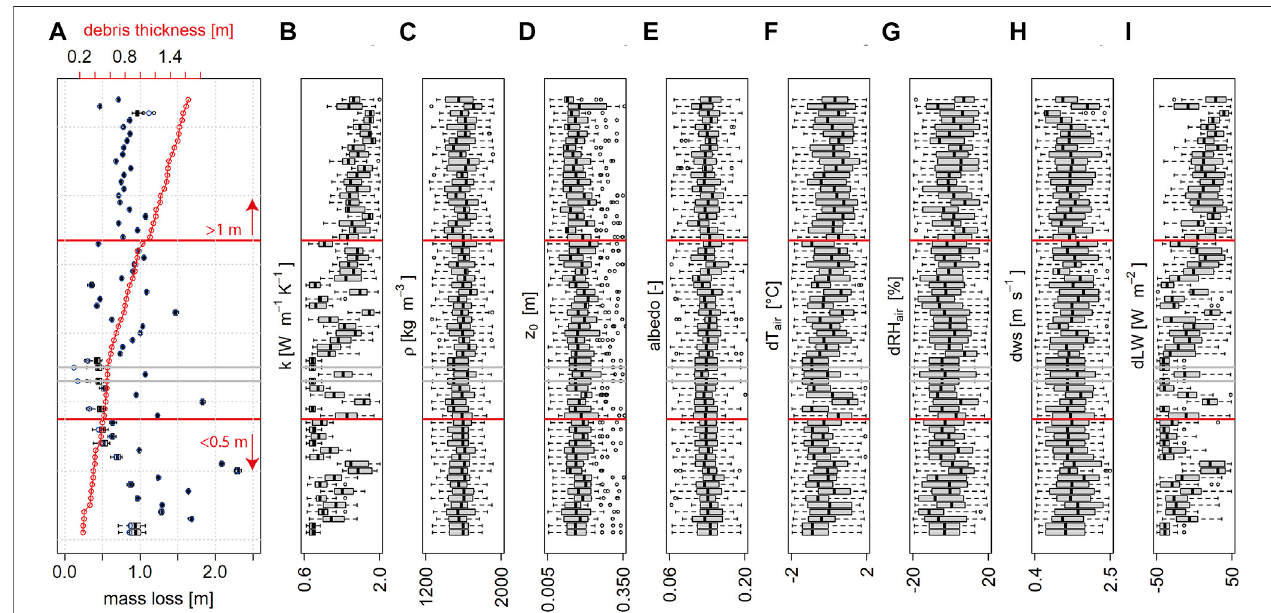
FIGURE 9 | (A) Modeled mass loss at locations where debris thickness observations are available. The boxplots cover the 25 model runs that most closely reproduceobservedmassloss. (B – I) Rangeofvariables(fromlefttoright: debrisconductivity, debrisdensity, surfaceroughness,surfacealbedo, aswellasuncertainty/ spatial variability ranges for air temperature, relative humidity of air, wind speed and incoming longwave radiation from surrounding terrain). Grey solid horizontal lines show cases where the observed melt could not be reproduced with any parameter combination.